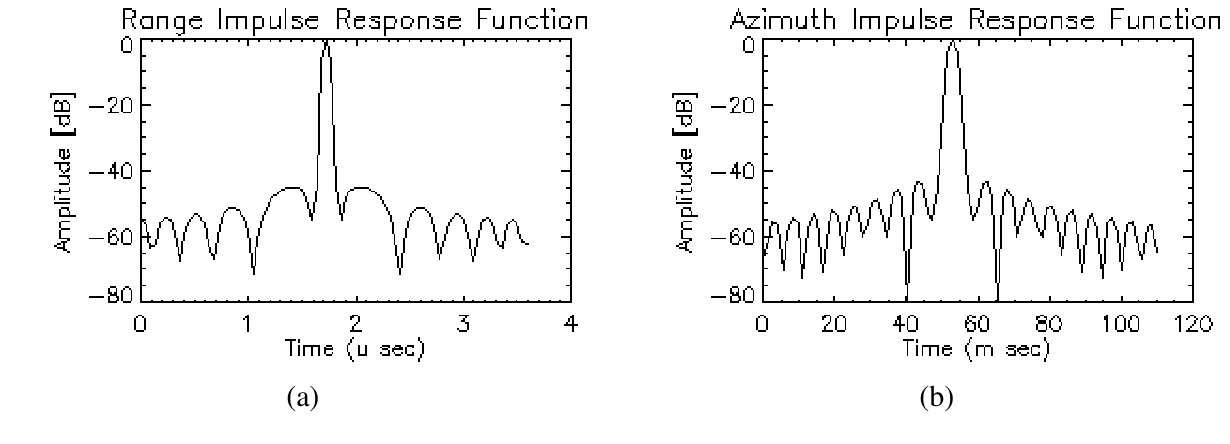
Figure 9 . The MAPSAR Impulse Response Function for range (a) and azimuth